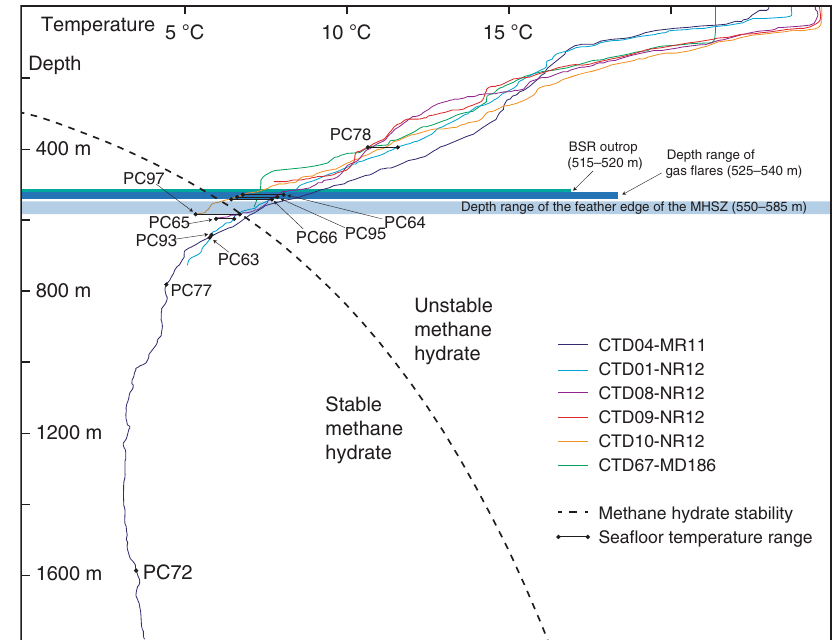
Fig. 4 Depth versus temperature diagram. Illustration showing the temperature pro fi les from conductivity, temperature, depth (CTD) casts, the location of piston cores, the bottom simulating re fl ector (BSR) outcrop, depth range of gas fl ares and the depth range of the feather edge of the methane hydrate stability zone. The stability of methane hydrate was calculated assuming pure methane in seawater 34 .